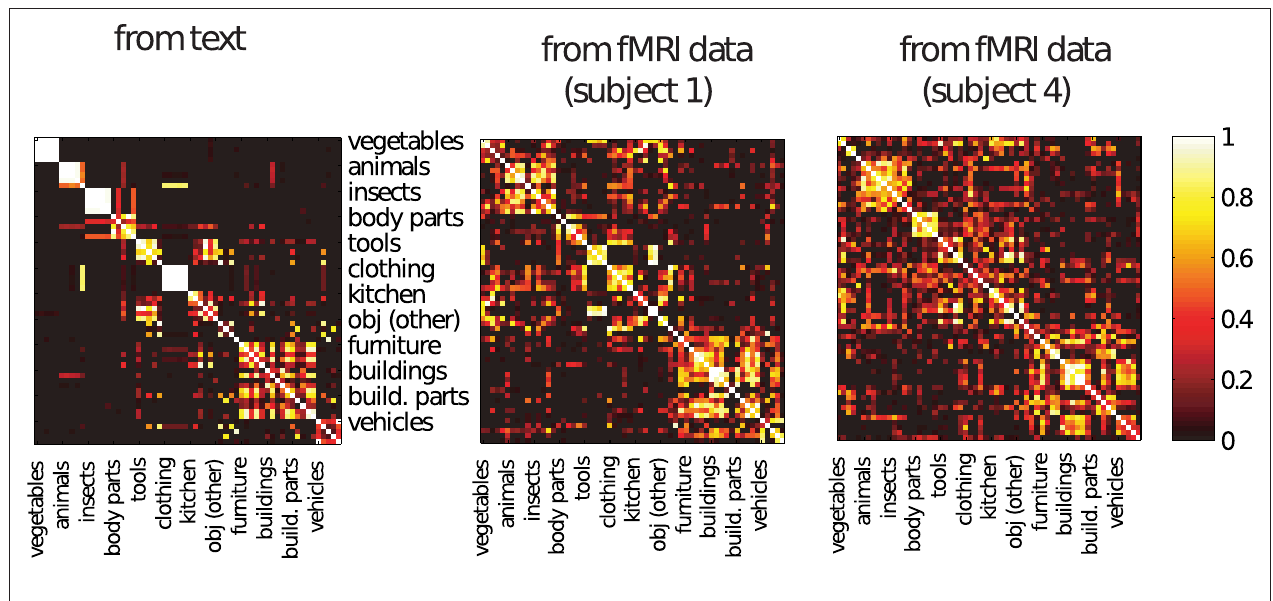
highest classification accuracy. These were obtained using a 40 topic model, the general pattern is similar for the other subjects. Note that the representations for concepts in the same category are similar when obtained from brain images and that this is also the case when those representations are derived